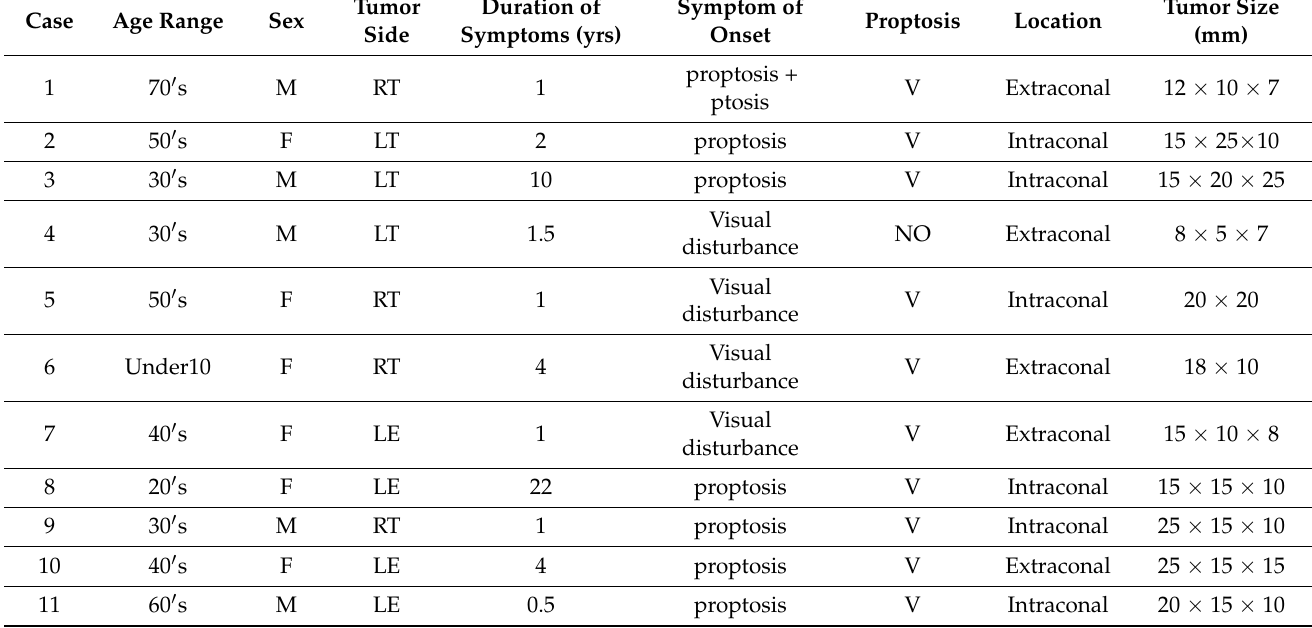
Table 2. Summary of clinical features of the OCVH cases. Proptosis was measured using exophthalmometer and was defined as a globe displacement of ≥ 2 mm compared to the other